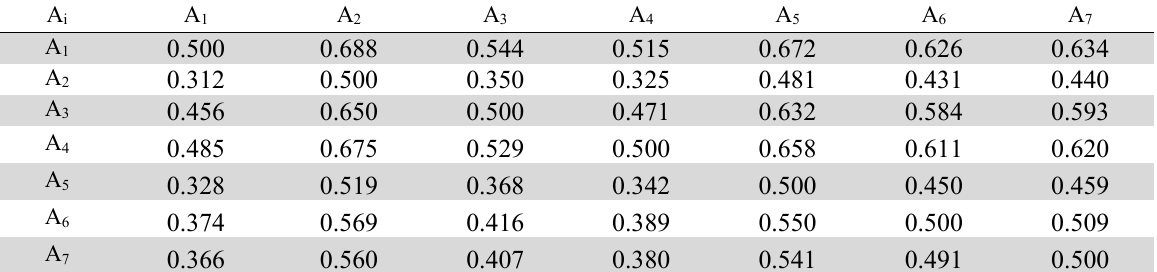
Evaluation matrix and computational result for the lean